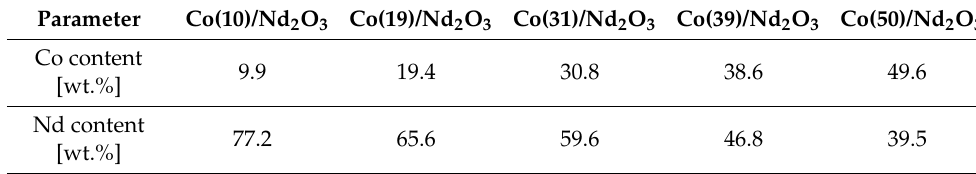
Table 5. Composition of reduced cobalt catalysts determined with